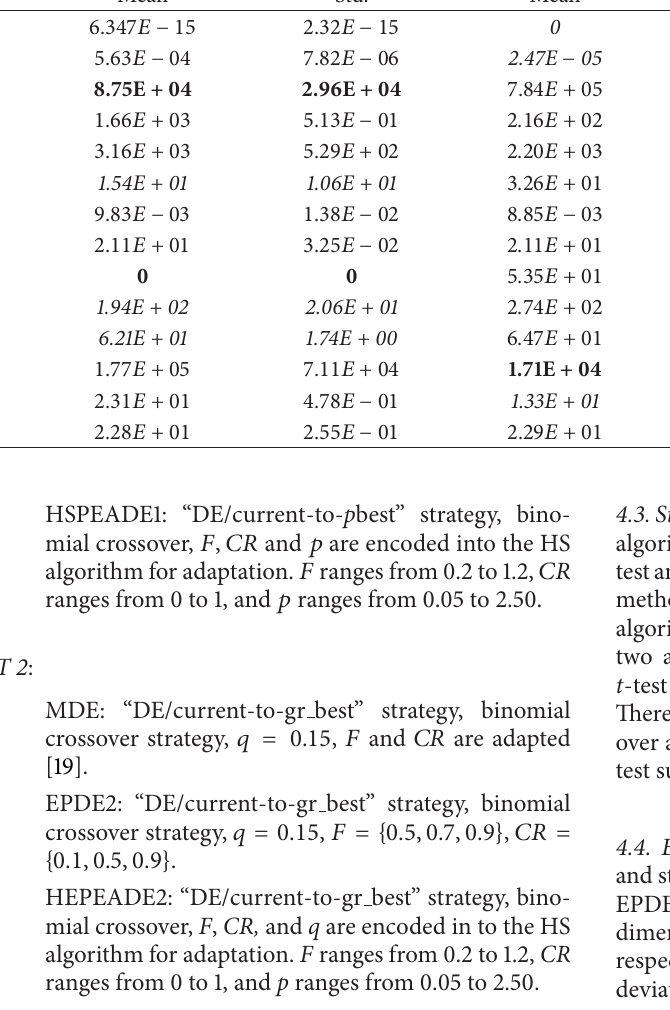
Table 2: Performance of JADE, EPDE1, and HSEPDE1 on 50D problems.